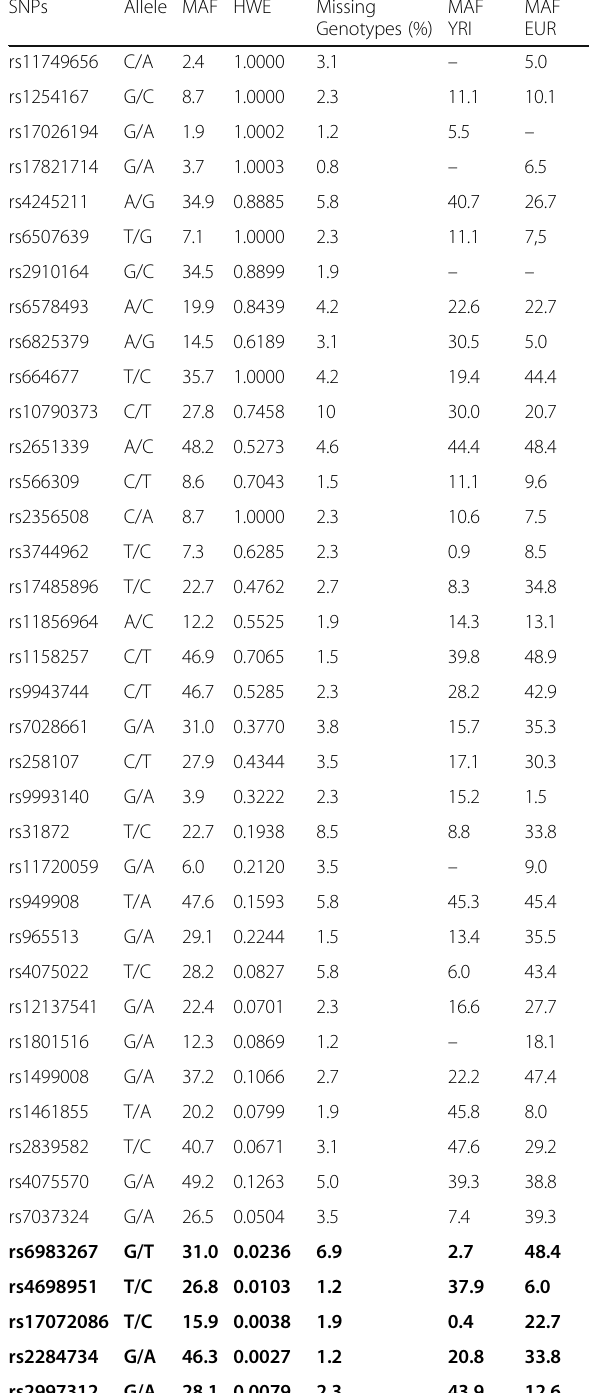
Table 2 SNPs evaluated according to Hardy-Weinberg equilibrium. The allele information were showed as Reference allele/Risk allele. P < 0.05 in bold. SNPs. Single nucleotide polymorphism; MAF: Minor Alleles frequency; HWE: Hardy-Weinberg Equilibrium. MAF YRI Minor Alleles frequency of population African; MAF EUR Minor Alleles frequency of European according with 1000 genomes project